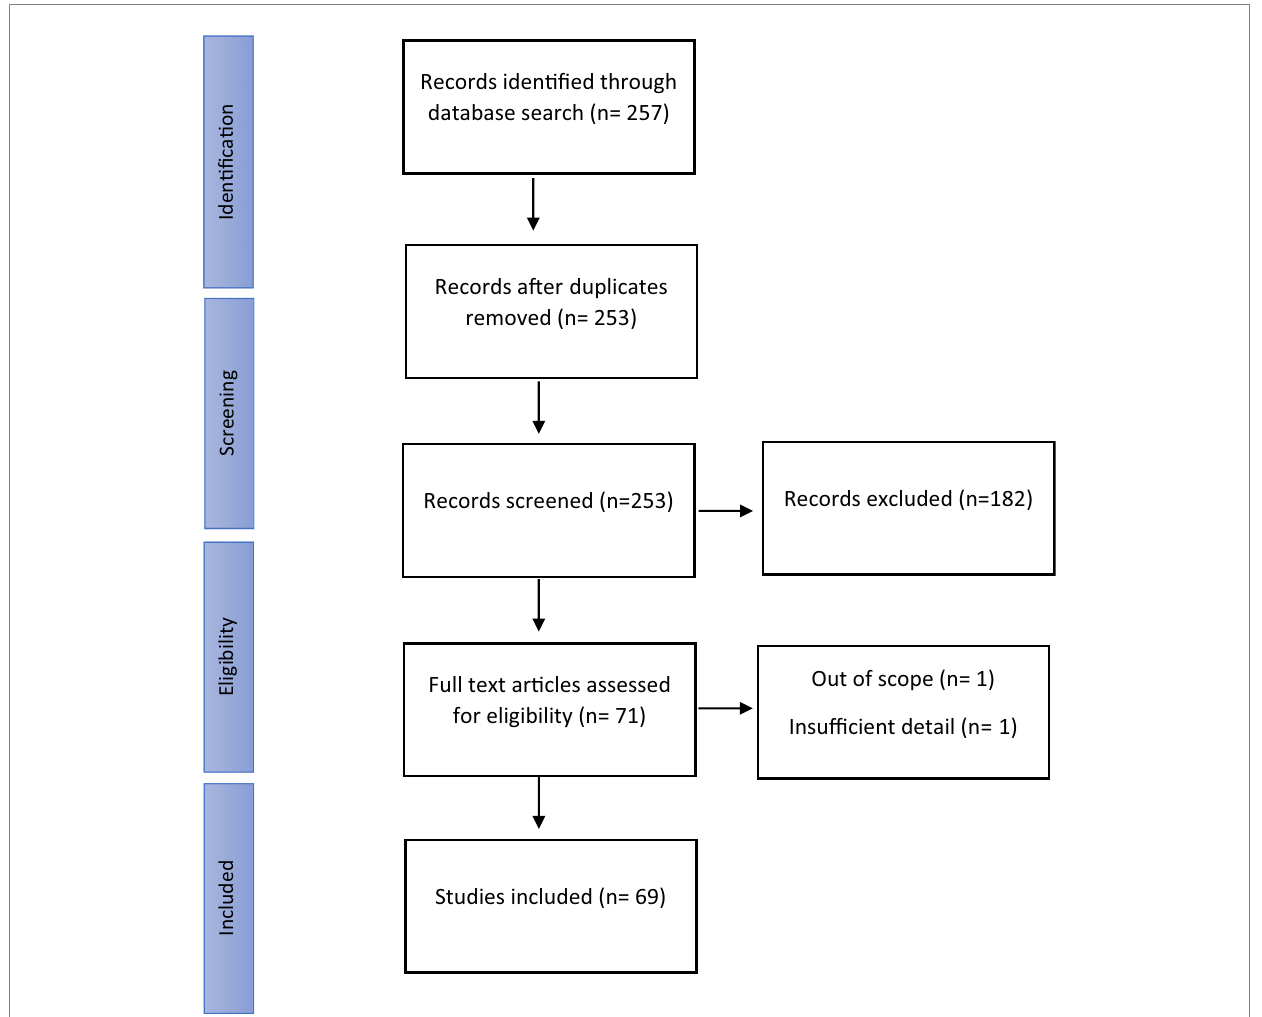
FIGURE 1 Diagram showing the information flow through the review: the number of records identified, included, and